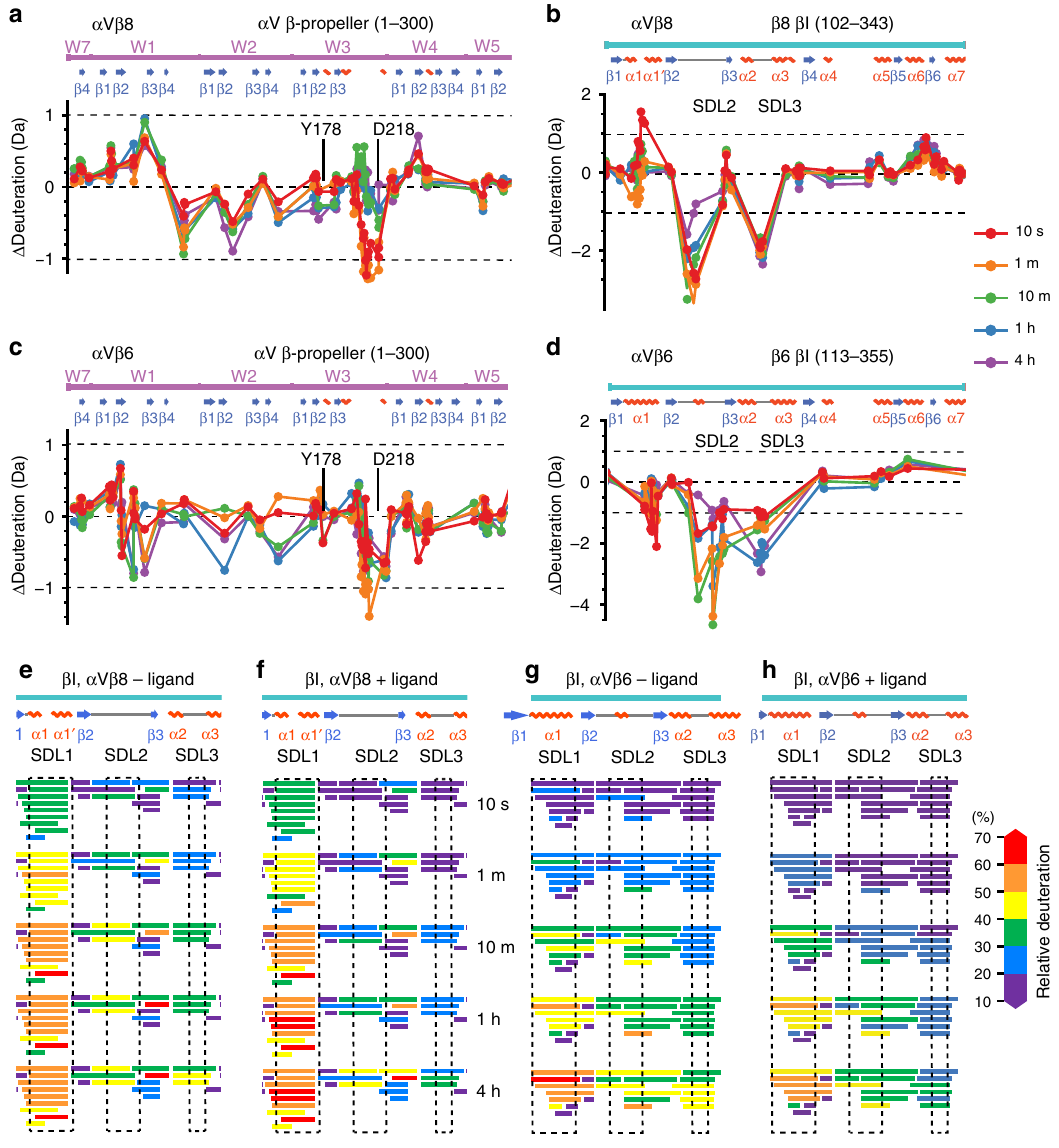
Fig. 6 Effect of ligand binding on deuterium exchange. a – d Differences in HDX with and without saturating concentrations of TGF- β 1 ligand peptide G 213 RRGDLATIHG 223 for α V β 8 and α V β 6 are shown for each peptide plotted at the midpoint of its sequence position for a portion of the β -propeller domain and the entire β I domain. The equation for subtraction was (D liganded − D unliganded . Differences > 1 Da (dashed lines) are considered meaningful. All HDX data are presented in Supplementary Figs. 1 and 2. e – h Details of the ligand-binding region of the β I domain. Exchange in each peptide is colored according to the